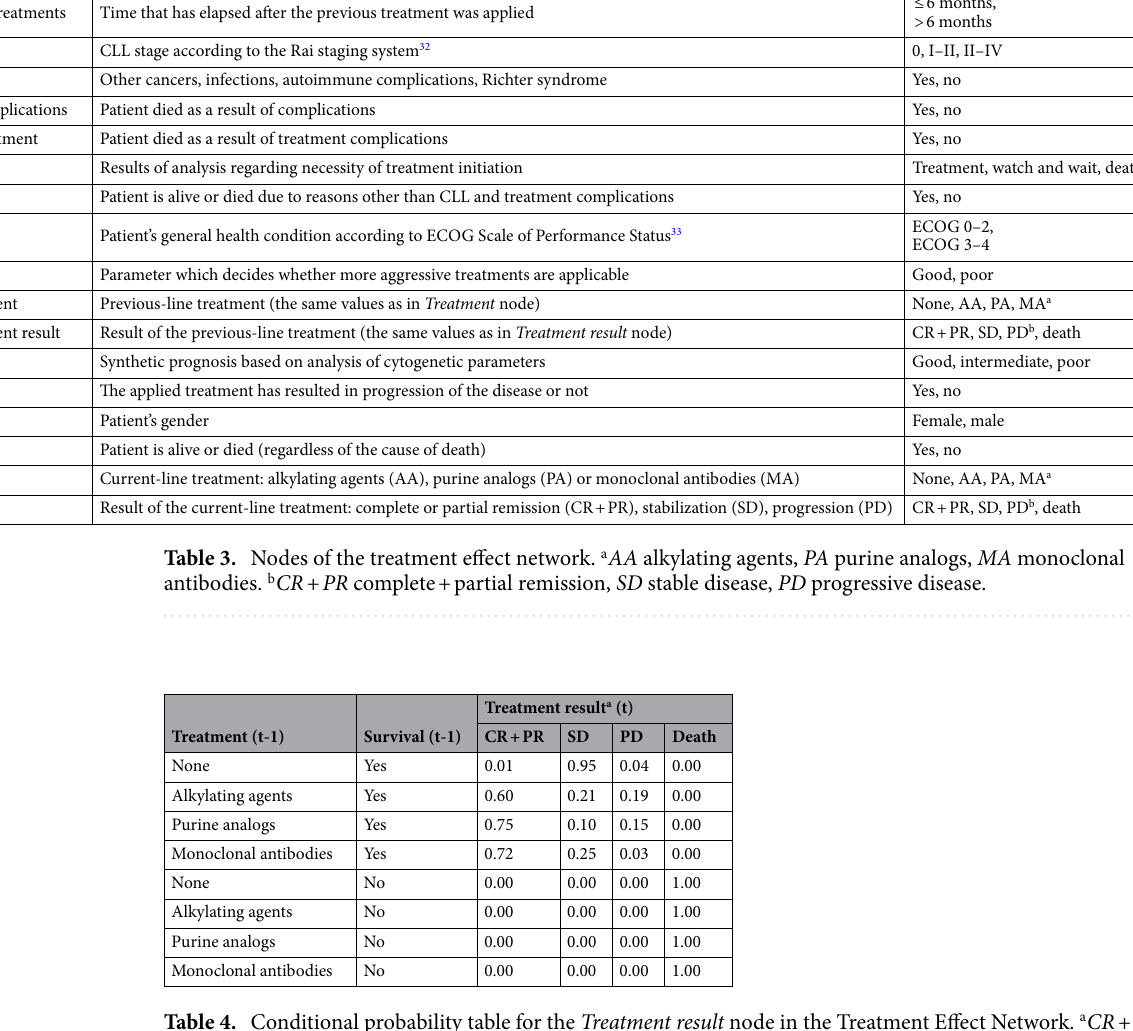
Table 4. Conditional probability table for the Treatment result node in the Treatment Effect Network. a CR + PR complete + partial remission, SD stable disease, PD progressive